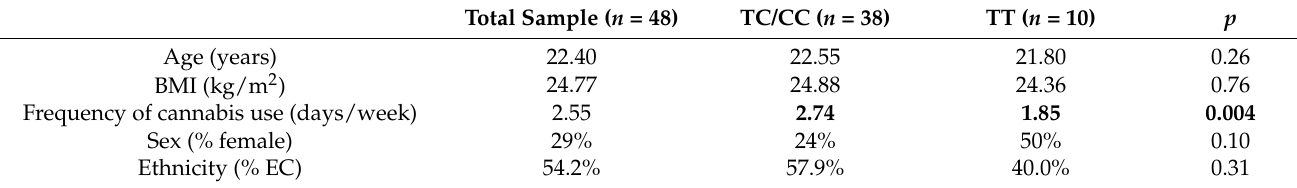
Table 1. Sample characteristics.